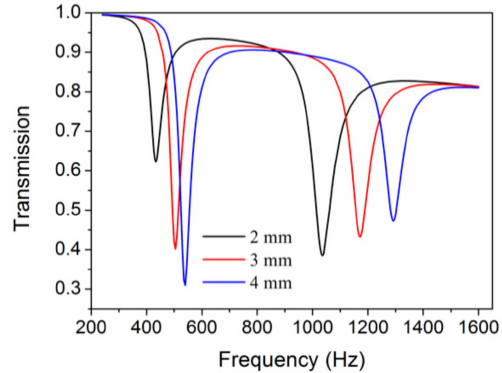
Figure 8. The transmission curves of NSHS-AMM with di ff erent diameters of the interior split